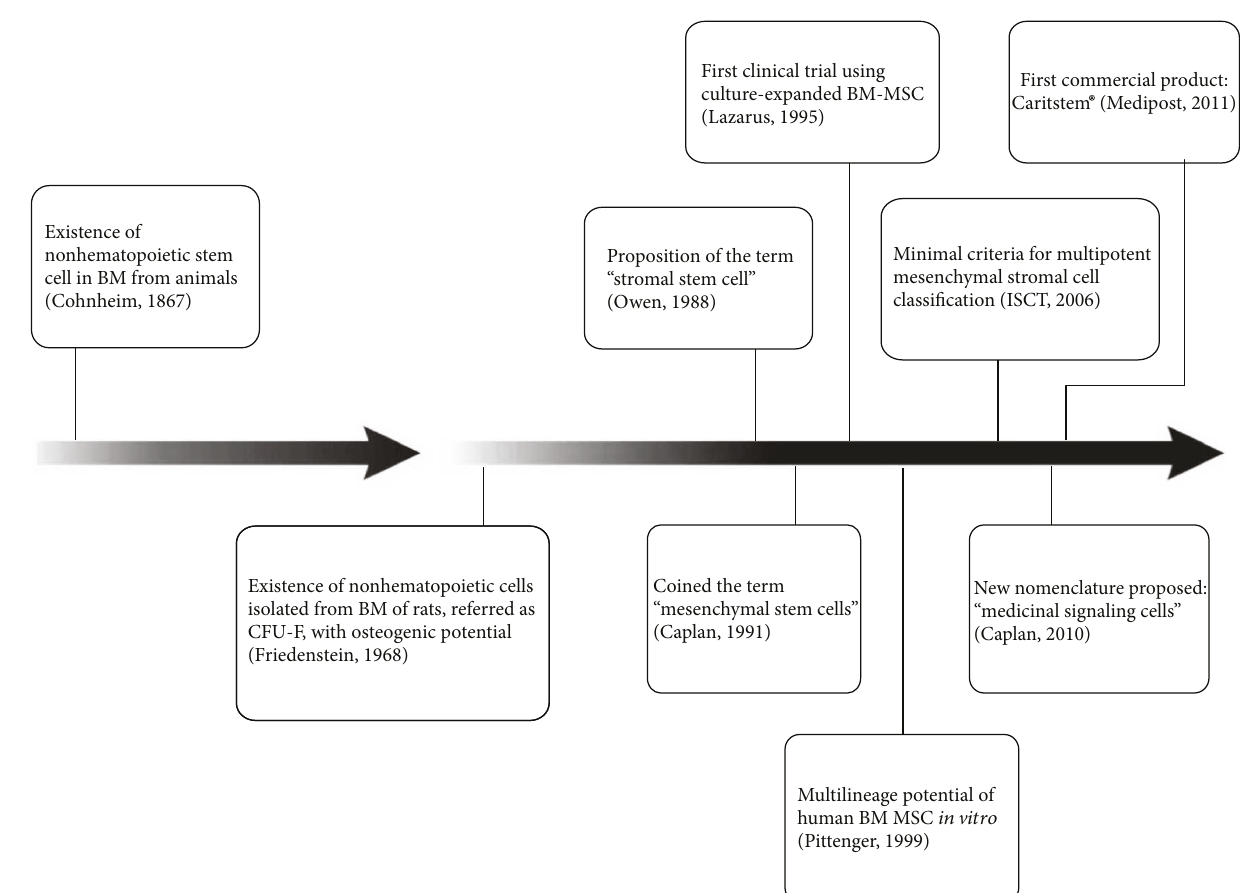
Figure 1: Schematic representation of the main fi ndings related to MSC discovery, characterization, and clinical application throughout the